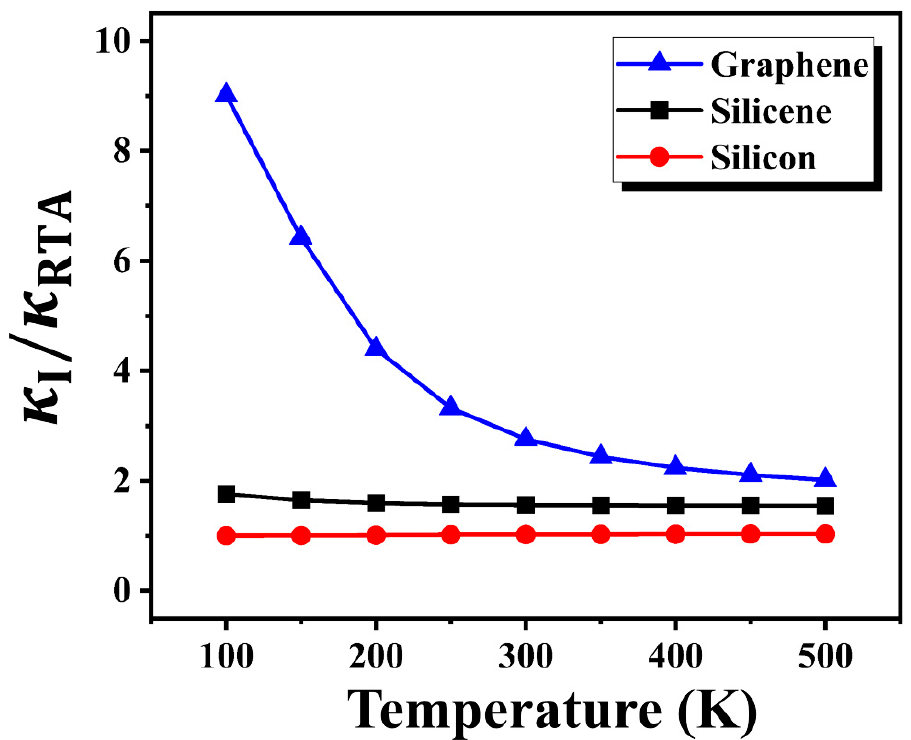
Figure 3. Thermal conductivities from the iterative solution ( κ I ) and relaxation time approximation ( κ RTA ) of the BTE for graphene, silicene, and silicon.